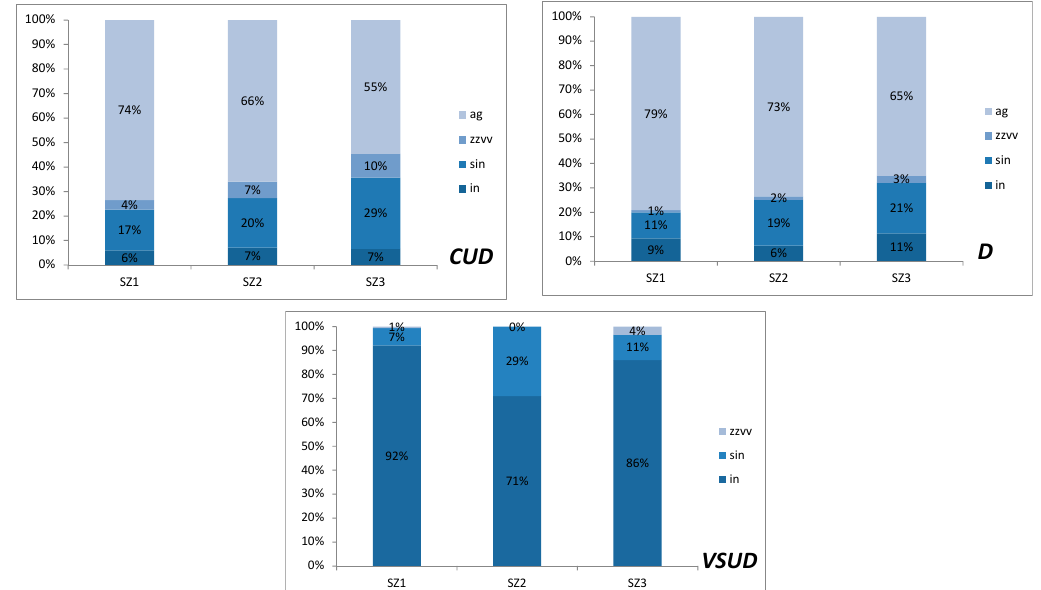
Figure 3. Land uses’ contribution to CUD , D , and the volume of water stored ( VSUD ).